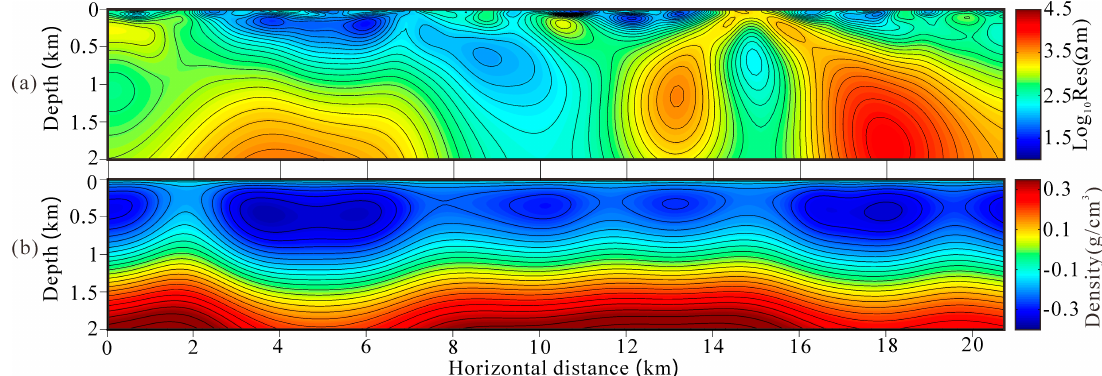
Figure 13. The results of separate inversion: resistivity model ( a ), residual density model ( b ).